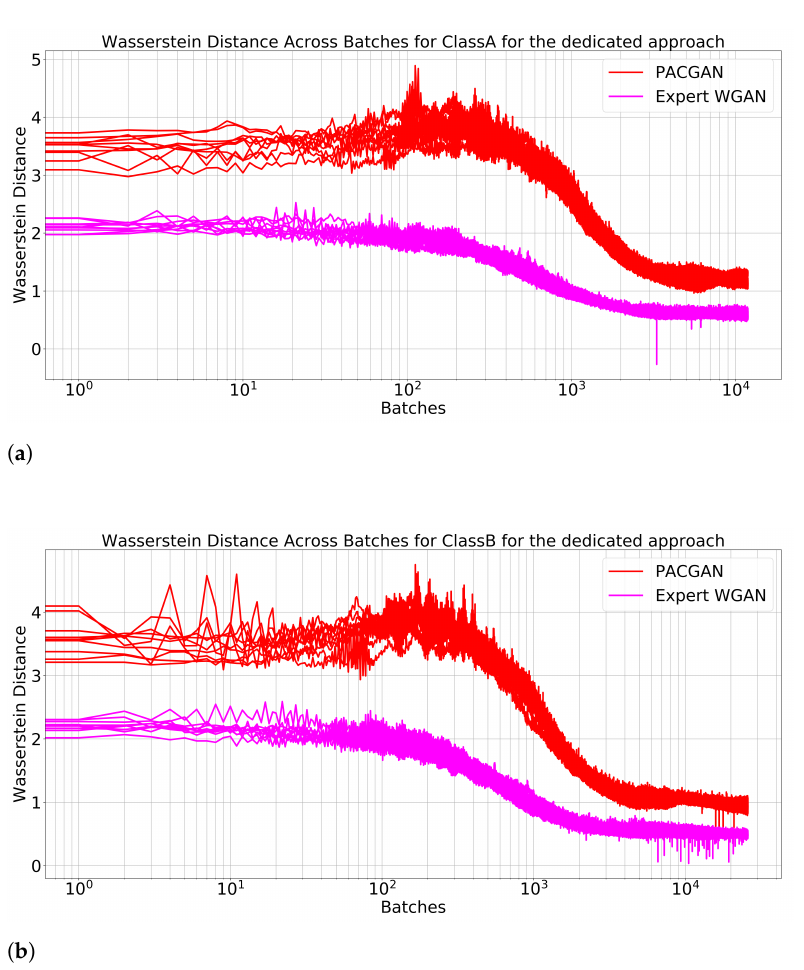
Figure 12. Training curves for classes A ( a ) and B ( b ) for the LORO-based cross-validation, when expert WGAN and PACGAN were